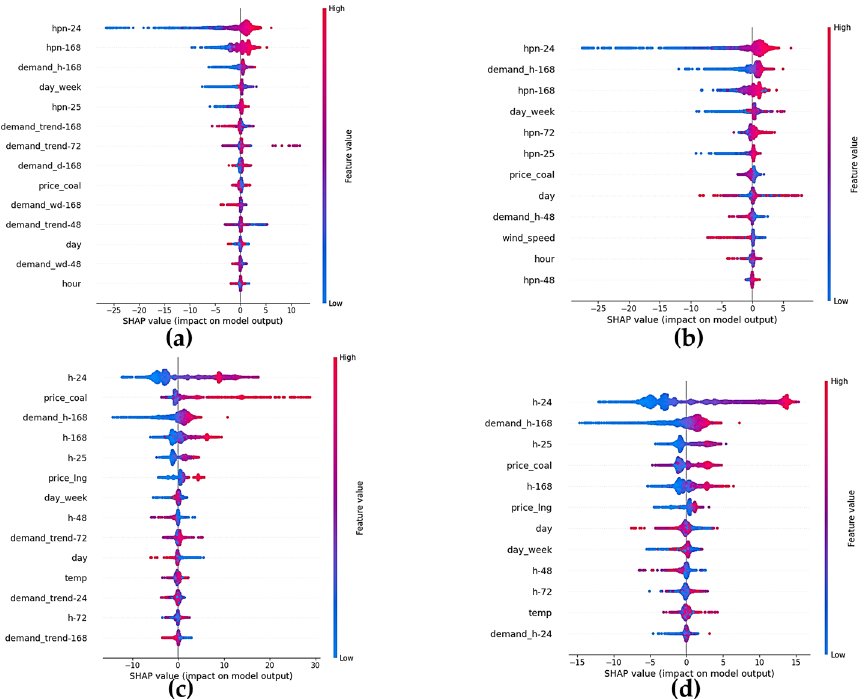
Figure 5. Calculate shapely value as forecasting ( a ) P fuel ( c ) P . Without decomposed data, calculate gains as forecasting ( b ) P fuel ( d ) P .